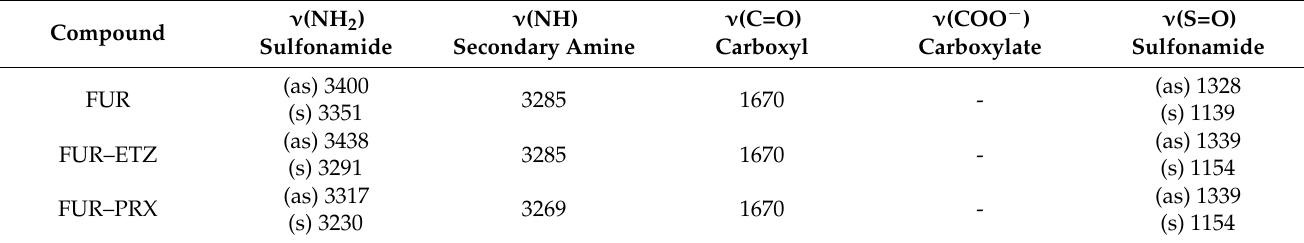
Table 3. Summary of relevant FT − IR vibrational frequencies (cm − 1 ) in the spectra of FUR, FUR–ETZ, and FUR–PRX. Compound